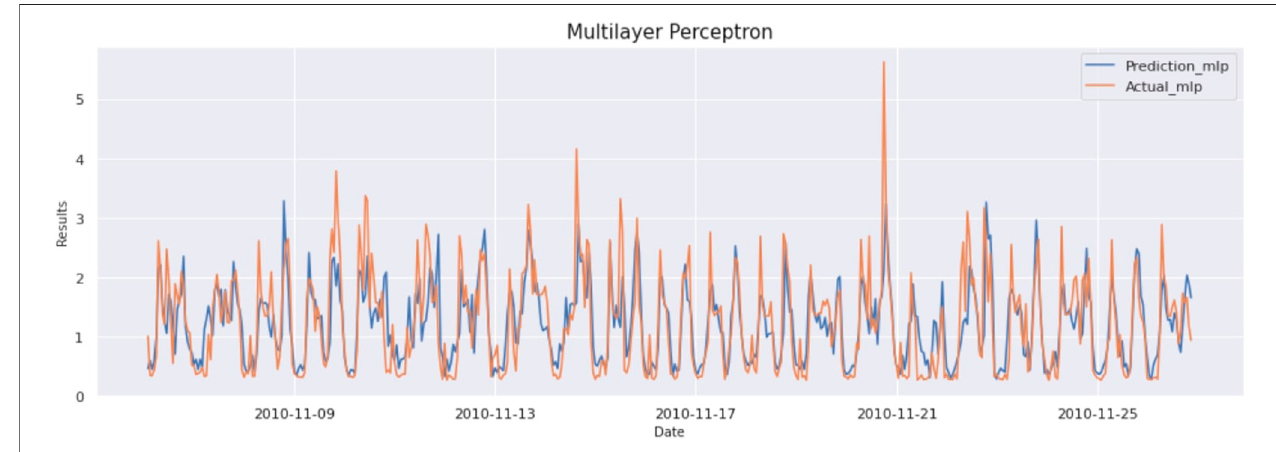
FIGURE 1 | Prediction vs Actual result of Multilayer Perceptron (Household Electricity